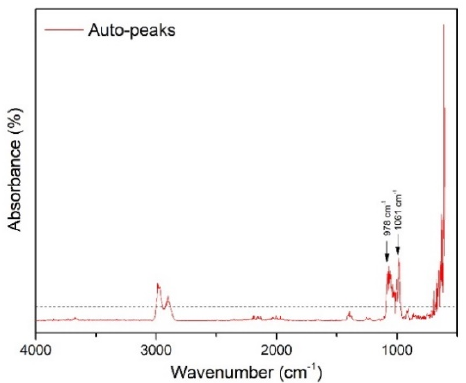
Figure 5. Two-dimensional Fourier transformation infrared correlation spectroscopy (2D-COS-FTIR) technique generated the auto-peaks plot.